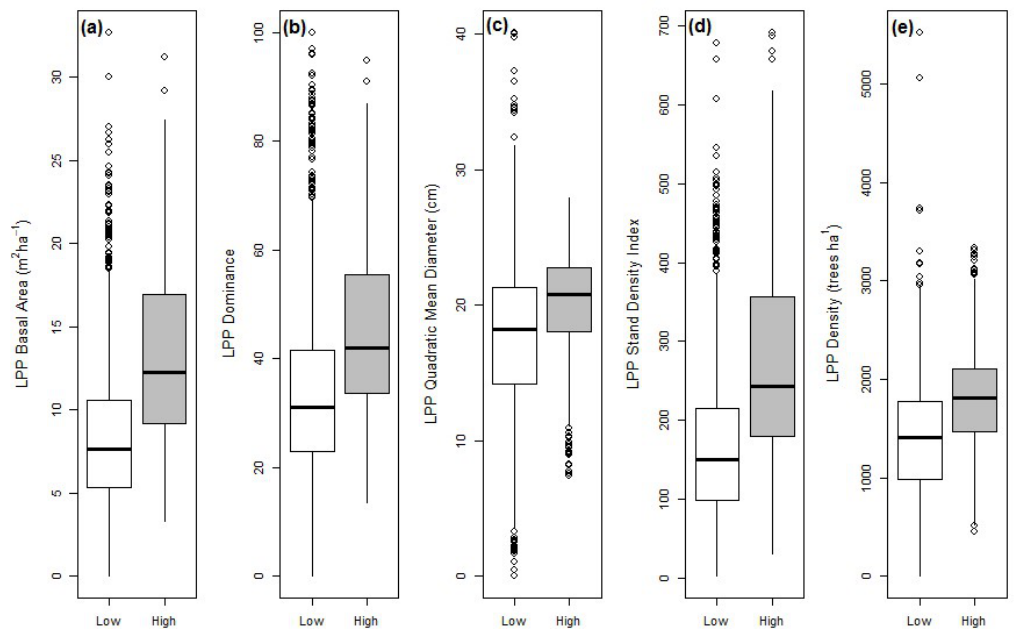
Figure 2. Distribution mean of host characteristics by subwatershed by low and high MPB-attack severity for lodgepole ( a ) basal area, ( b ) dominance, ( c ) quadratic mean diameter, ( d ) stand density index, and ( e ) density. See Table 1 for variable descriptions.